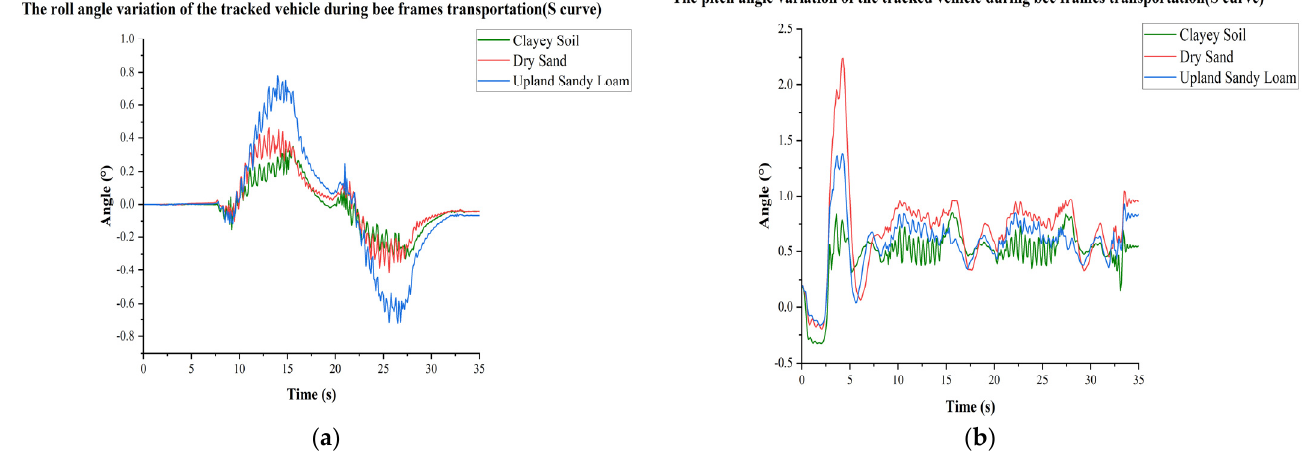
Figure 20. Variation of ( a ) roll values under each pavement condition when the loading box is fully loaded with bee frames (s-turn), ( b ) pitch values under each pavement condition when loading box is fully loaded with bee frames (s-turn).